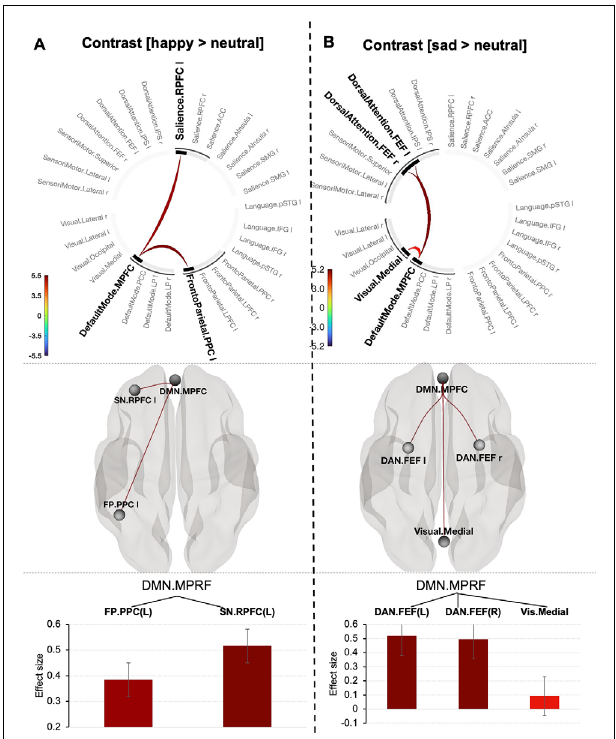
FIGURE 4 | Connectogram of networks (top row), corresponding glass brain (middle row) and effect sizes of individual connections within a cluster (low row) for happy (A) and sad (B) prioritization effects [the connectivity threshold p < 0.001, cluster threshold p-FWE corrected ( p < 0.05)]. Vertical color bars indicate T-test statistics for individual connections. Glass brain visualizes spatial location of connections comprising each component where a sphere represents the center of the corresponding network. The red and blue lines depict positive or negative correlations between networks. Effect sizes: the Y axis represents Pearson correlation values where the sign indicates the direction of the effect. Error bars represent standard deviations. The color of the effect size bars corresponds to the color of relevant connections in the connectogram.